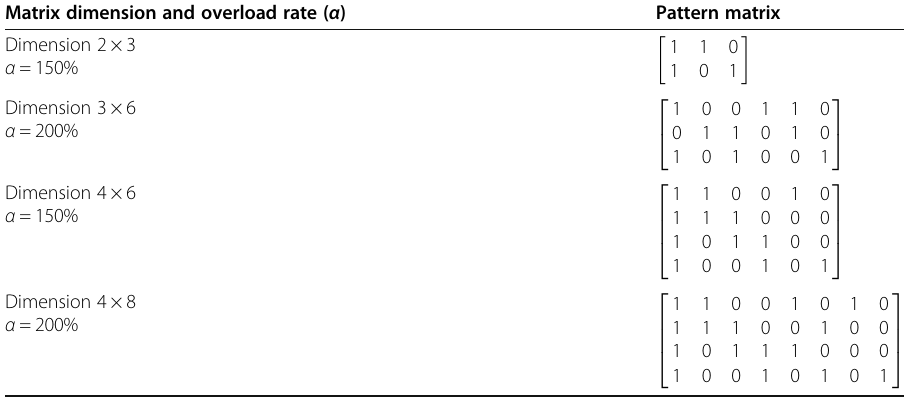
Table 1 PDMA pattern matrix. The pattern matrix of different dimensions selected for simulation Matrix dimension and overload rate ( α )